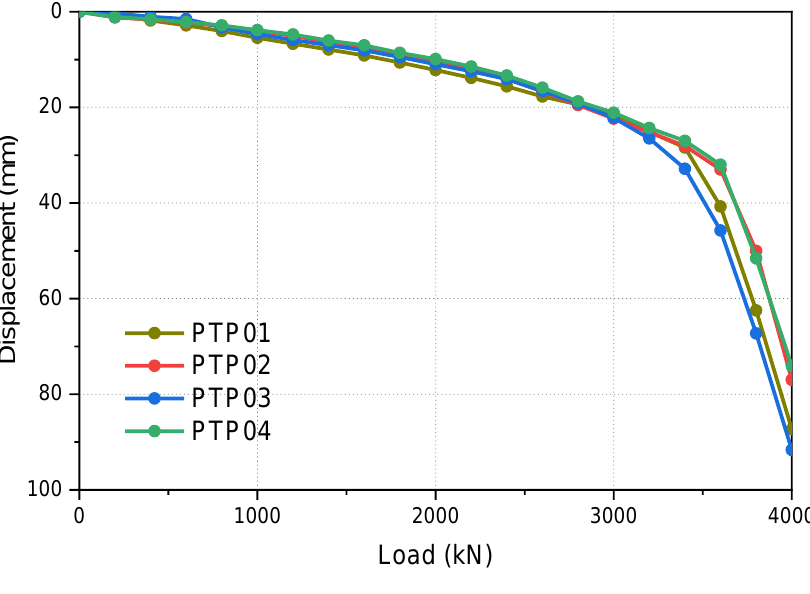
Figure 3. Compression test result.